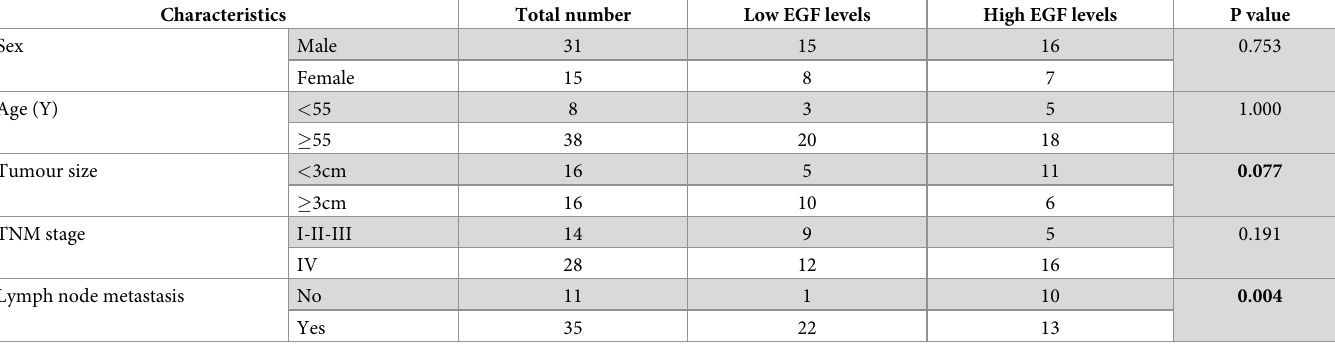
The association between serum EGF levels and clinical characteristics of lung- and head and neck tumour patients was determined using a Chi-square test and a Fisher’s exact test depending on whether all expected cell counts exceeded